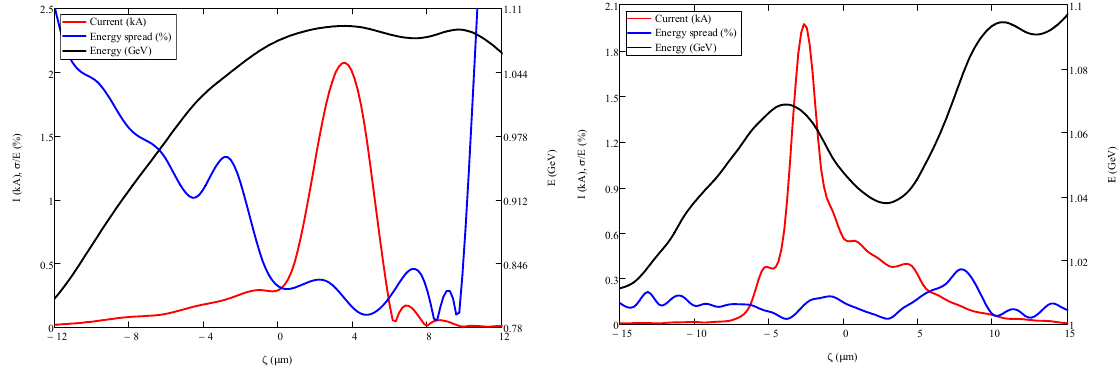
Figure 3. Energy, current and energy spread slice profiles as a function of the intrabunch ζ coordinate, for the beam distributions Rossi–1 ( left ) and Marocchino–1 ( right ) at undulator